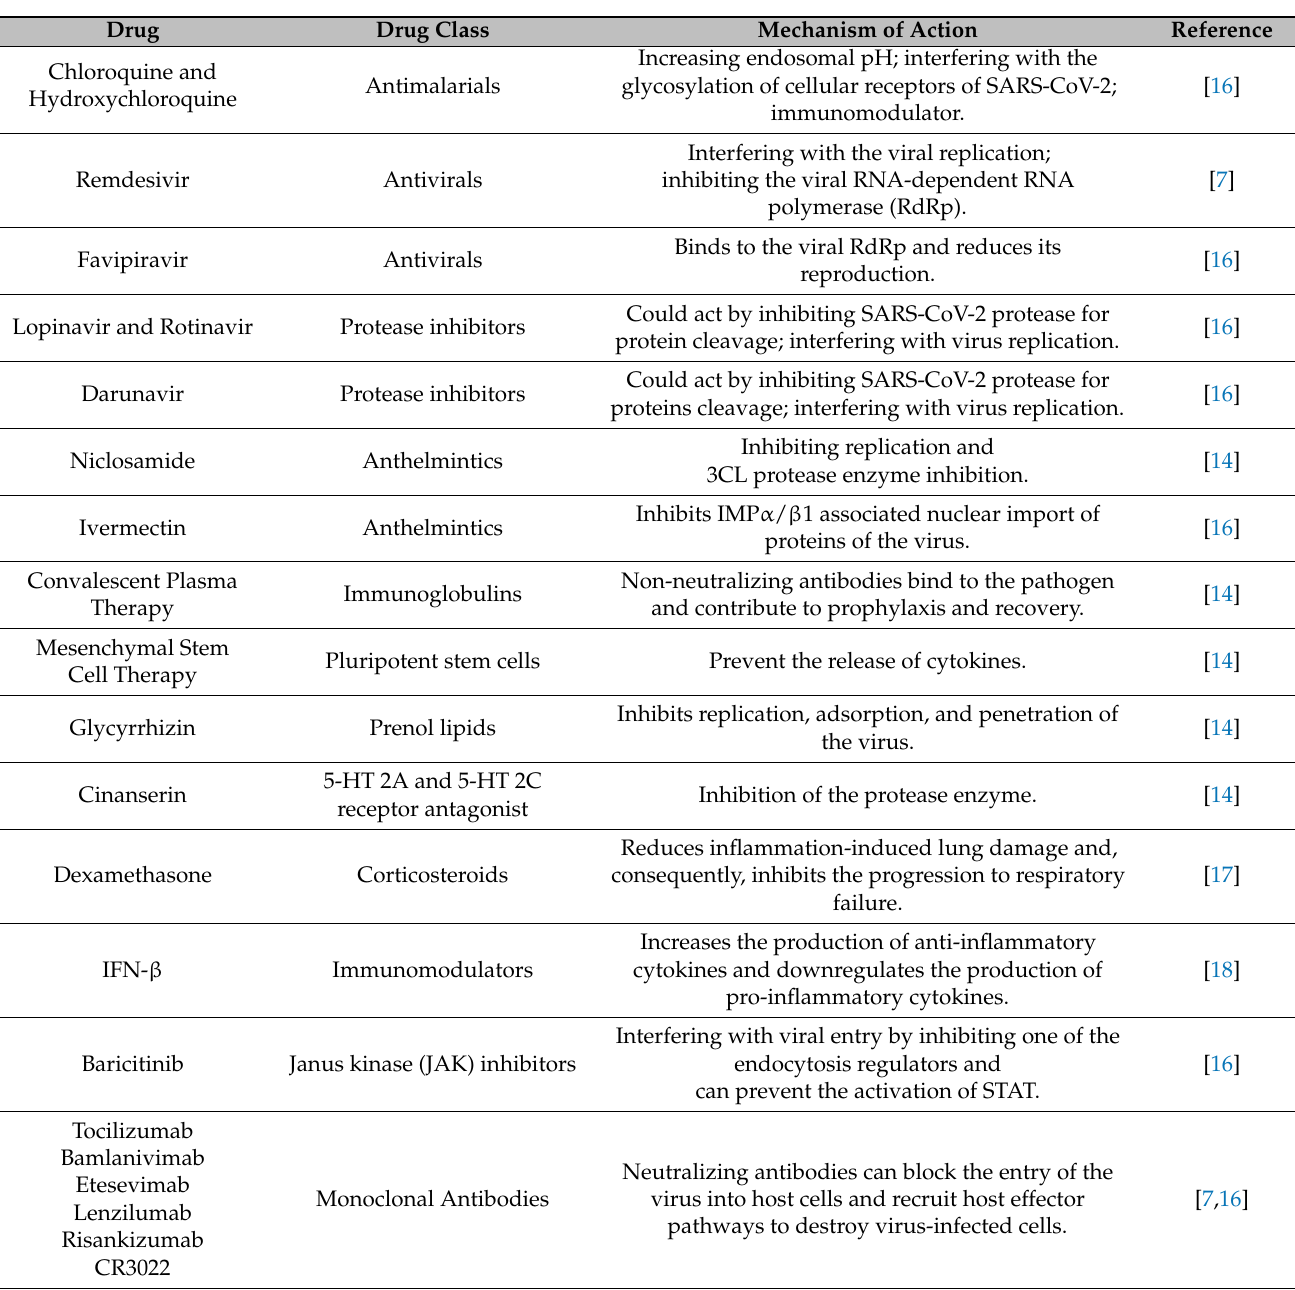
Table 1. Potential therapeutic agents used in the treatment of